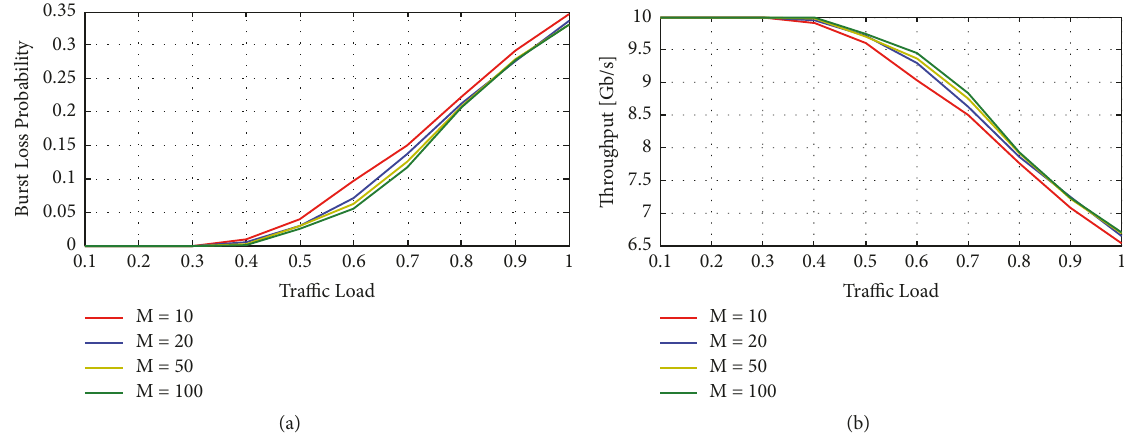
Figure 19: Network congestion for different values of M: (a) burst loss probability versus traffic load [12]; (b) throughput versus traffic load (N = 8 , % VPN = 0.5